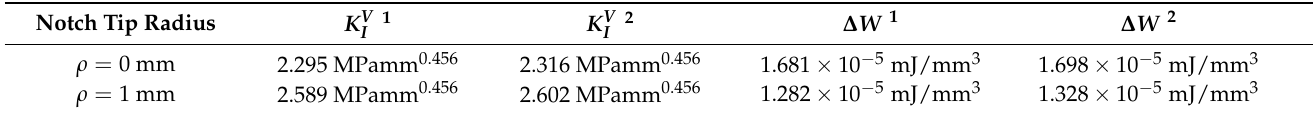
Table 1. N-SIF and ESED results of a basic study on double-notched V-plate ( W = 10 mm, a = 1 mm, 2 α = 90 ◦ ) in plane strain formulation.